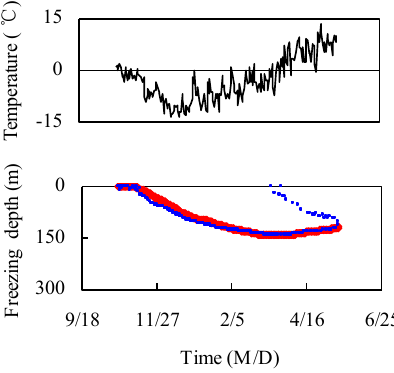
Figure 3. With the observed soil surface temperature at the corresponding times, the comparison between measured (red dashed line) and simulated (blue dashed line) freezing depth of soil from October 2005 to June 2006.